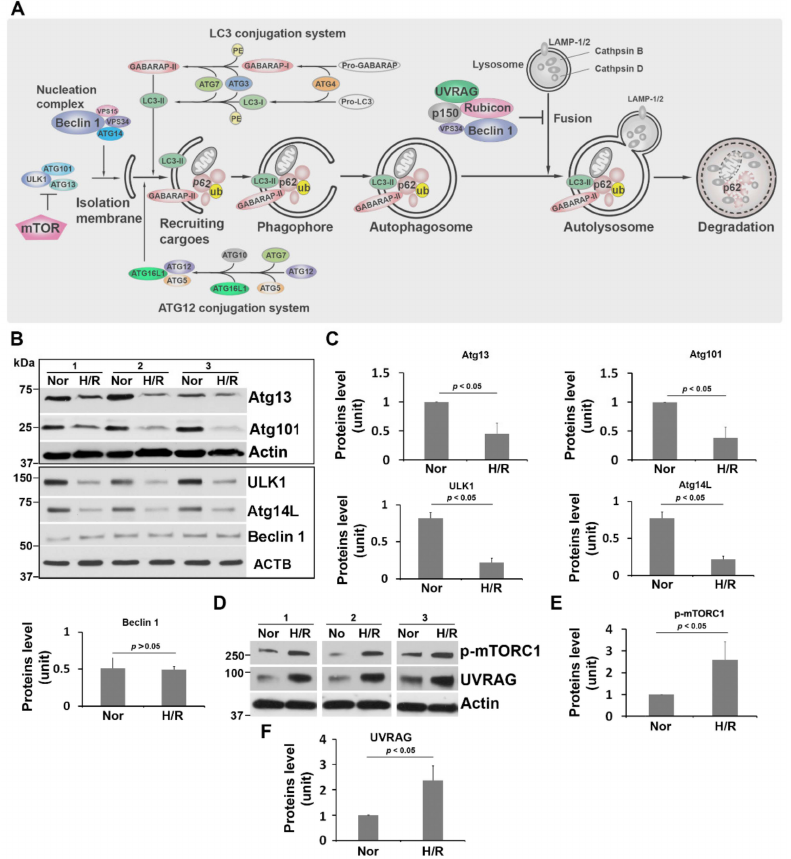
Figure 1. H/R treatment dysregulates the regulators involved in the initiation of isolation membrane formation in PHTs. ( A ) Diagram showing the key molecules involved in regulating the whole processes of autophagic flux. ( B ) Immunoblotting showing the effect of H/R conditions on the abundance of key molecules in ULK1 initiation complex and nucleation complex as shown in ( A ). ( C ) The intensity of target bands shown in ( B ) was measured and statistically compared between normoxia (Nor) and H/R treatment. ( D – F ) Western blotting and quantitative analyses of indicated proteins. ACTB ( β -actin) was monitored as a loading control among samples. Data are expressed as mean ± SEM and analyzed by a Student’s t -test ( n =